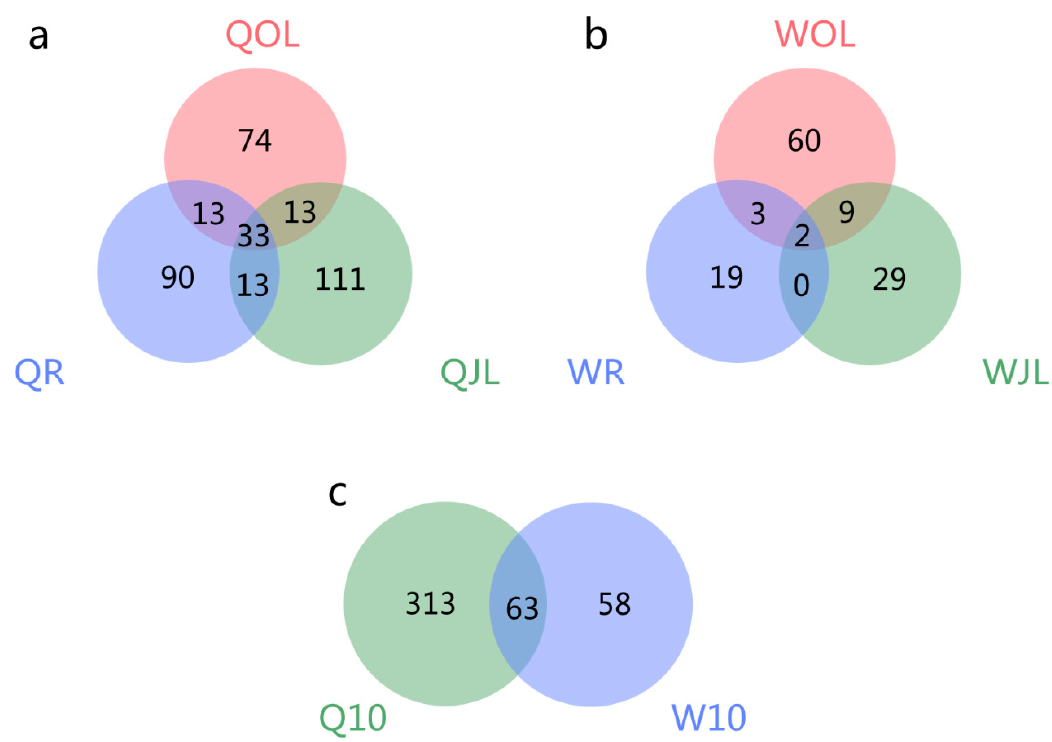
Figure 8. Venn diagram of the overlap of differential alternative splicing (DAS) genes in the root, juvenile leaves and old leaves of B. napus cultivars Qingyou10 (QY10) and Westar10 (W10) under boron deficient conditions: ( a ) QY10; ( b )W10; and ( c ) QY10 and W10 under B deficient conditions; QR, root of QY10; QOL, old leaves of QY10; QJL, juvenile leaves of QY10; WR, root of W10; WOL, old leaves of W10; WJL, juvenile leaves of W10. Table 3. Thirty-three and two differential alternative splicing genes detected in root, juvenile leaves and old leaves simultaneously in B. napus cultivars Qingyou10 and Westar10, respectively. Cultivars